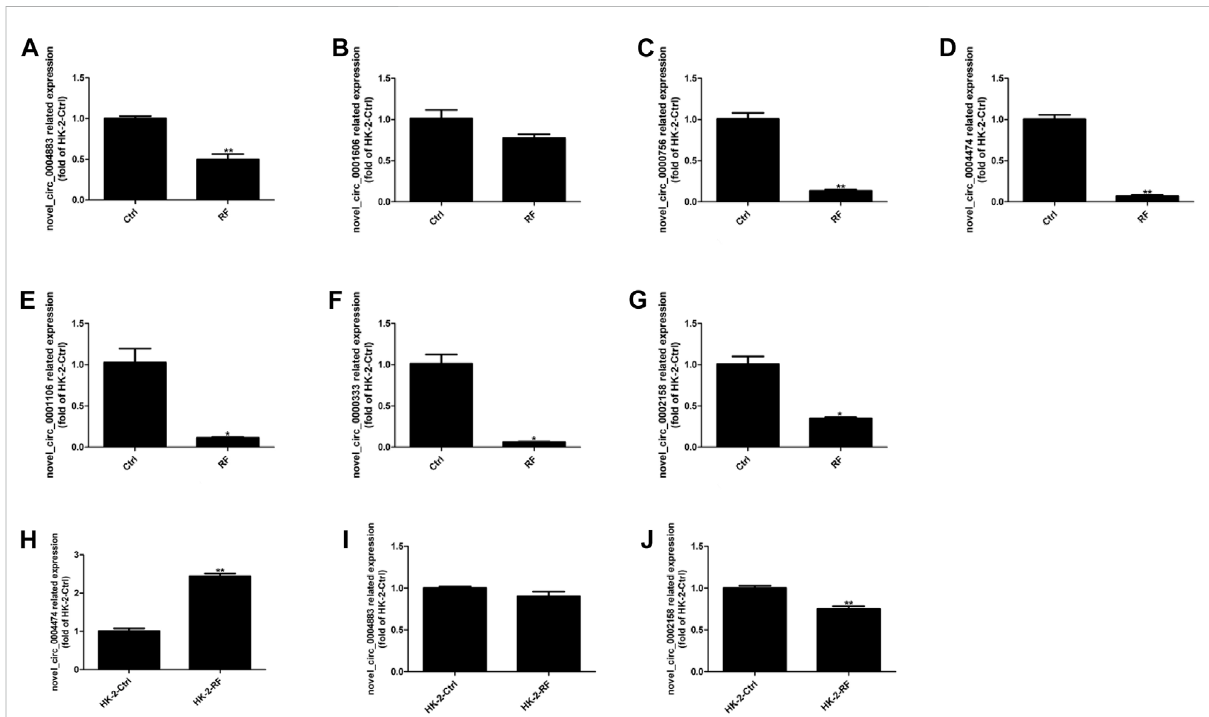
FIGURE 2 Expression levels of circRNAs were assessed by quantitative reverse transcription polymerase chain reaction (qRT-PCR). (A – G) The qRT-PCR results of seven candidate circRNAs indicated the accuracy of RNA-sequencing. (H – J) The expression levels of three circRNAs were detected in the cell model ofrenal fi brosis (RF). Comparisonswerecarried out with independent samplet-tests,and data have beenrepresentedas mean ± SD.* p < 0.05, ** p < 0.01, and *** p <